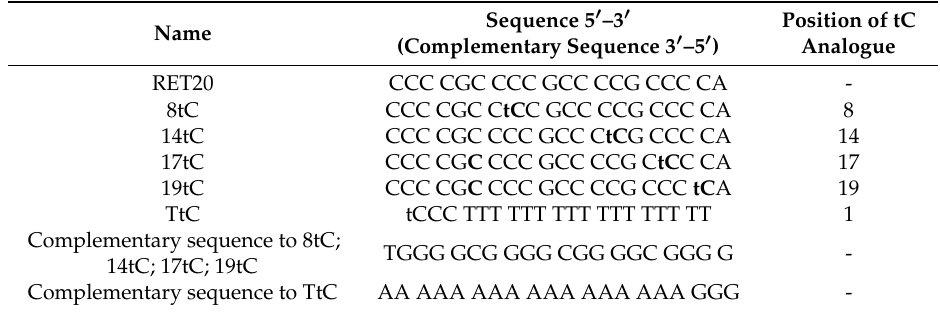
Complementary sequence to